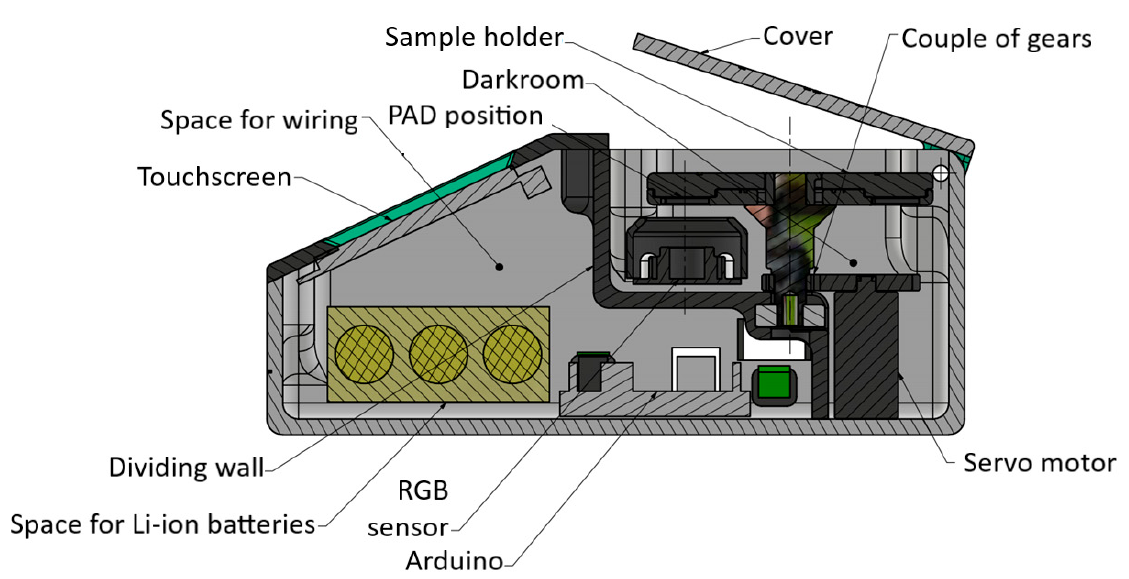
Figure 1. RGB-detector’s placement scheme.